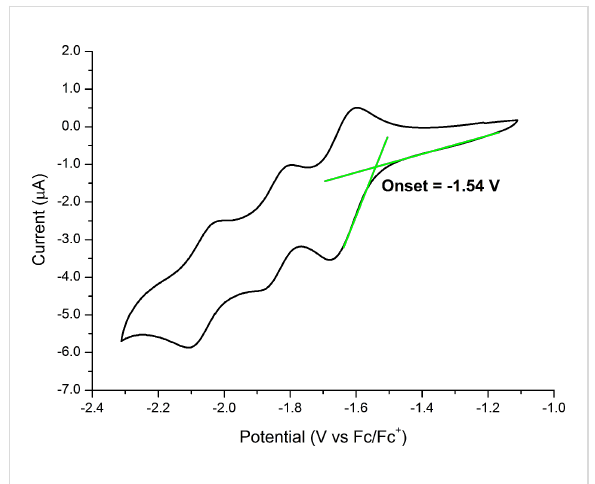
Figure 2: Cyclic voltammogram for Al(Op) 3 recorded at room tempera- ture in CH 2 Cl 2 solution using TBAPF 6 as the electrolyte and ferrocene as an internal standard. Scan rate: 0.1 Vs − 1 . The graphical estimation of the first reduction wave onset is highlighted in green. The LUMO energy level, − 3.26 eV, was computed by using the onset of the first reduction wave at − 1.54 V